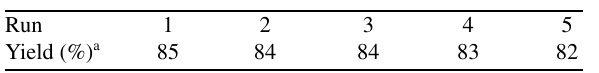
/nano-TiO catalyst in the preparation 2 2